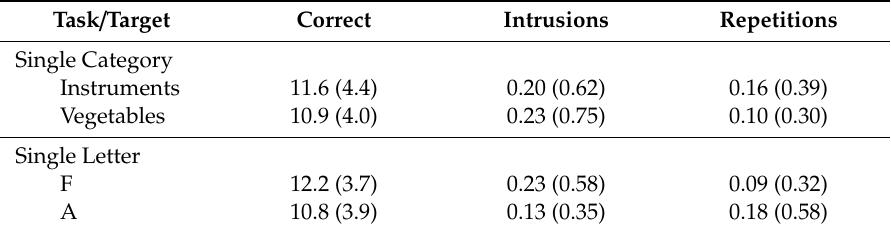
Table 2. Mean number of correct responses, intrusions, and repetitions in each of the verbal fluency tasks (standard deviation in parentheses) for the bilinguals analyzed in the present